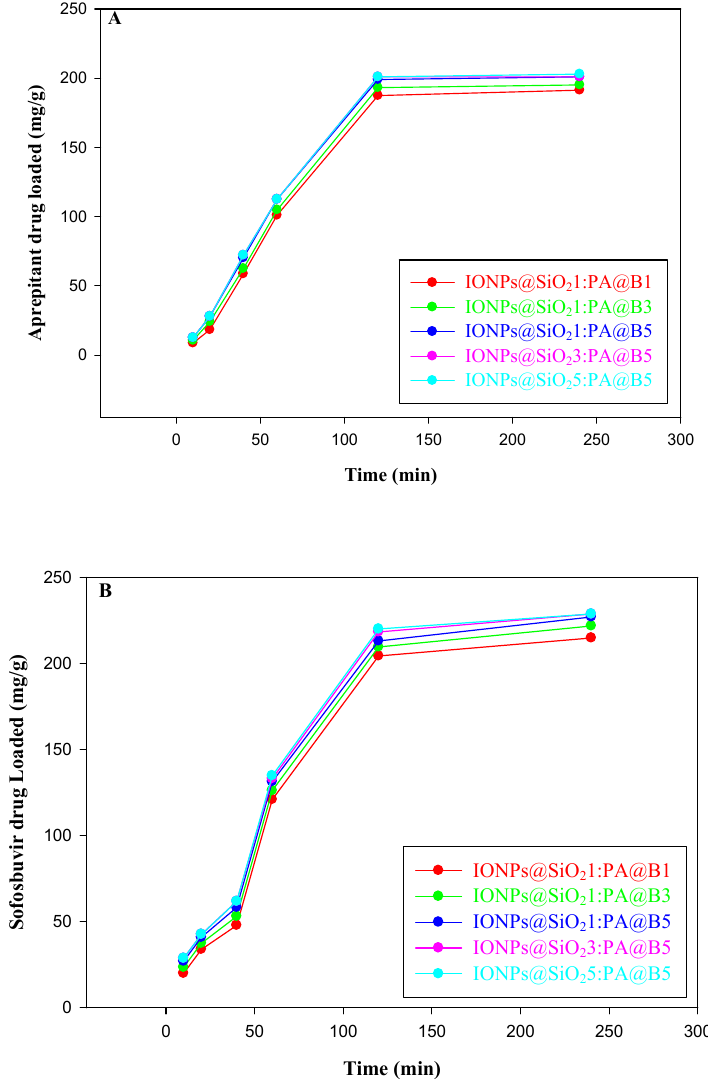
Figure 8. Loading of drugs into the fabricated MCM-PA@B at different time points: aprepitant ( A ); sofosbuvir ( B